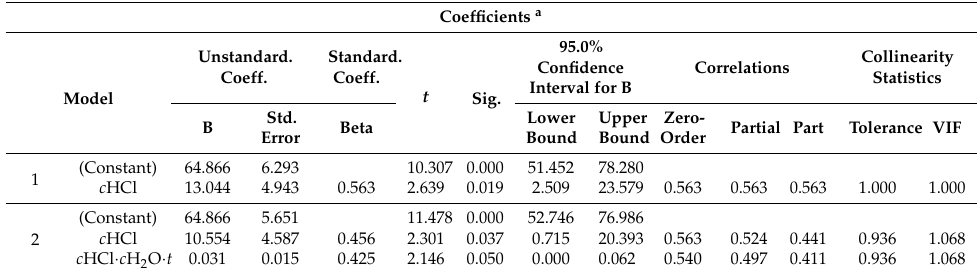
Table 4. Linear regression models generated by means of stepwise procedure.